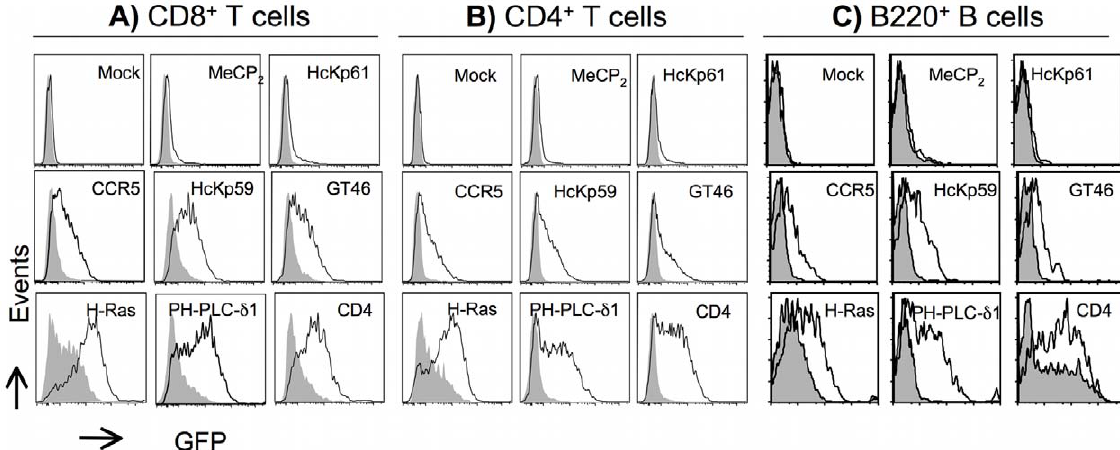
Figure 3. Quantitative differences in the detection of the capture of various fluorescent proteins in redirected trogocytosis. A) OT-I T cells were co cultured with HEK-Fc c RII cells transiently expressing the indicated protein fused to GFP. Shown are histograms of GFP fluorescence on OT-I cells co cultured with the target cells in the presence (white histograms) or absence (grey histograms) of the Y3 mAb. Top, middle and bottom panels provide respectively three illustrative examples of proteins that are not significantly transferred, poorly transferred or efficiently transferred onto OT-I T cells during trogocytosis. B) As in A) except that OT-II T cells were used instead of OT-I T cells. C) As in A) except that MD4 B cells coated or not with an anti- k chain mAb were used instead of OT-I T cells. The profiles represented in top, middle and bottom rows formed the basis for the semi-quantitative classification of proteins presented in Table 1 and 2: not transferred ( 2 , fold induction around , 1.5), poorly transferred ( + , fold induction in the range (1.5–3) and efficiently transferred ( ++ , fold induction . 3). Note that, in most cases, preferential transfer of proteins was analyzed in parallel with CD4 + , CD8 + and B cells allowing comparison not only between the various proteins but also between the effector cells themselves. Similar results were obtained in 2 other experiments.